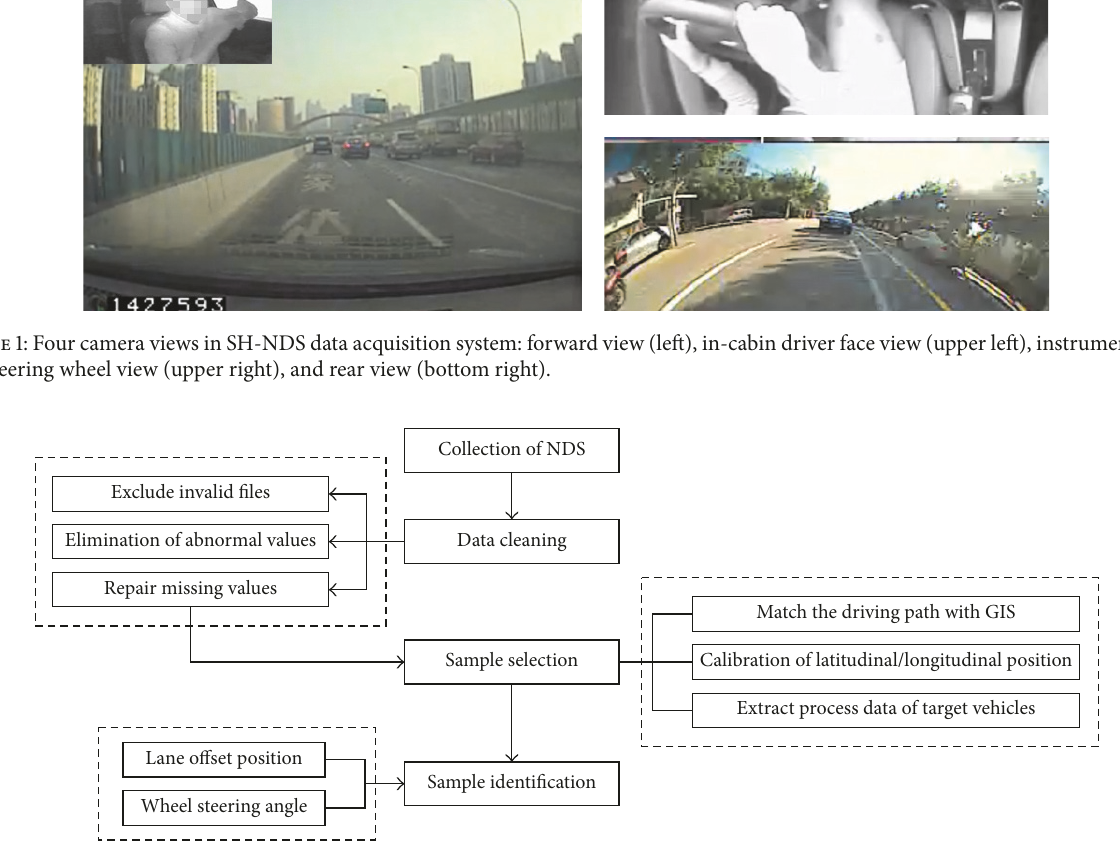
Figure 2: The procedure of data collection and